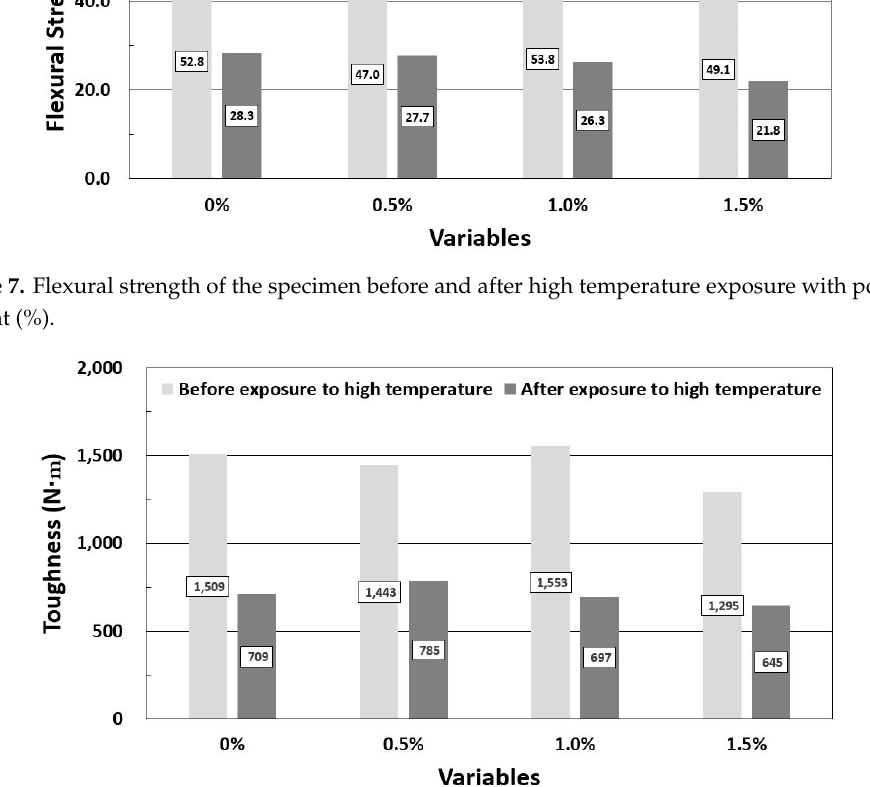
Figure 8. Flexural toughness of the specimen before and after high temperature exposure with polymer content (%).